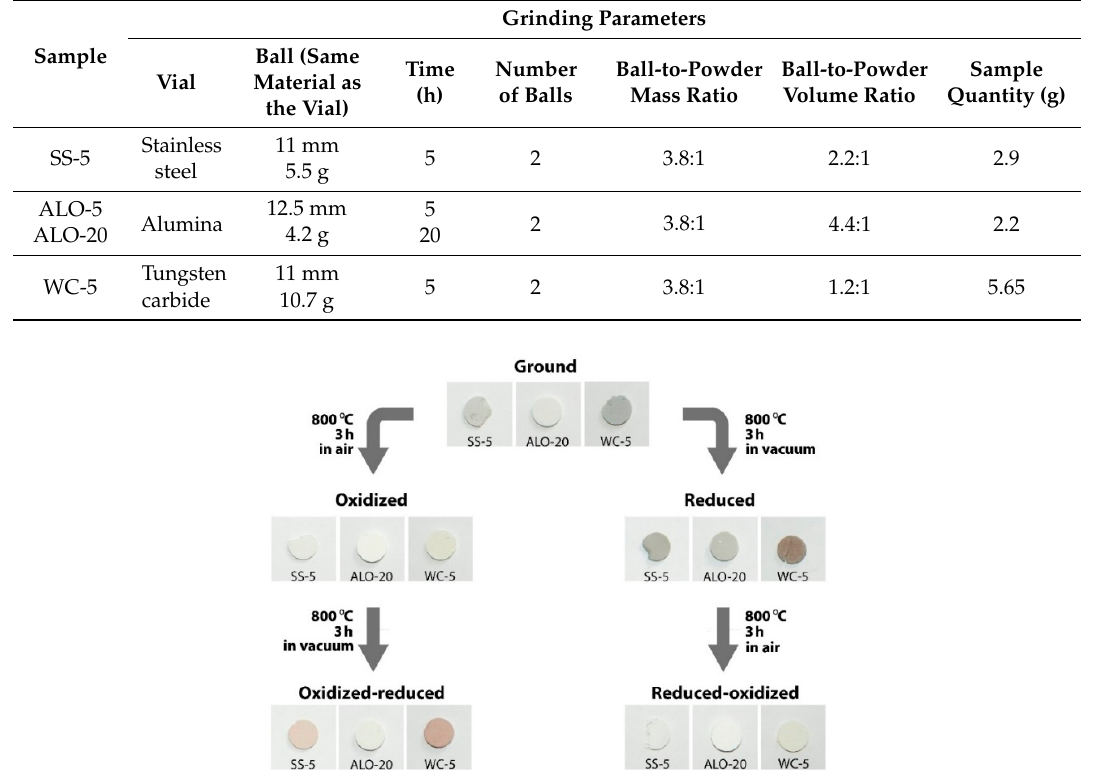
Table 1. Grinding parameters used for high-energy ball-milling.